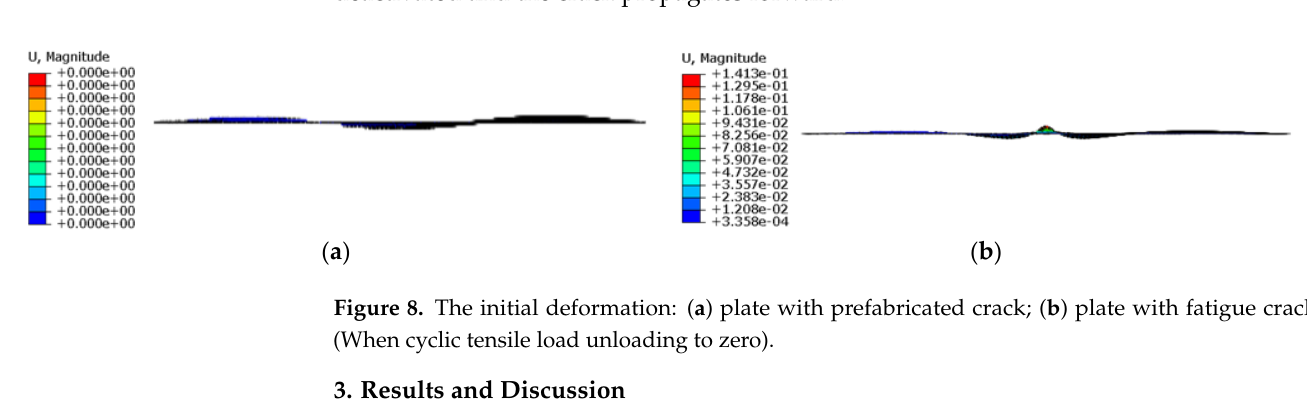
Figure 7. The initial stress distribution: ( a ) plate with prefabricated crack; ( b ) plate with fatigue crack (When cyclic tensile load unloading to zero).